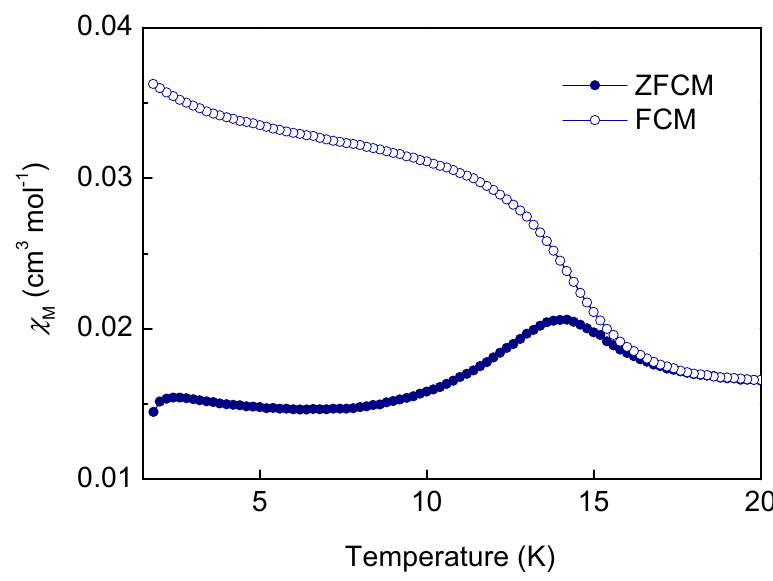
Figure 8. FC and ZFC magnetization plots of compound 2 at the field of 50 Oe.